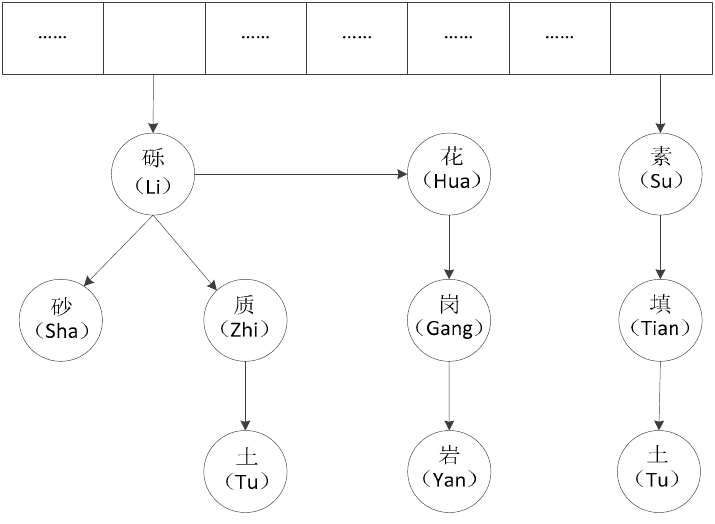
Figure 11. The storage structure of geological vocabulary.